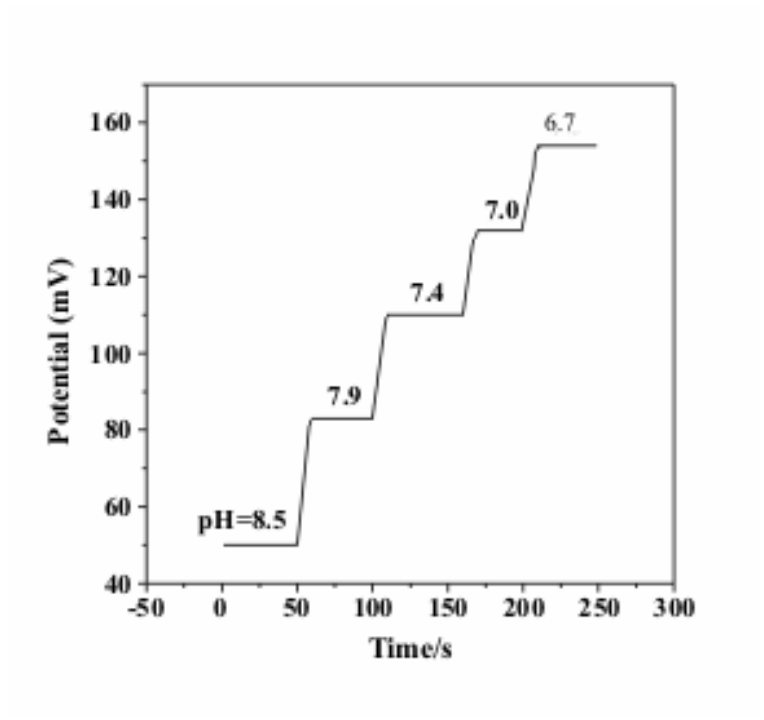
Figure 2 . Response of the membrane electrode based on 10.0 wt % SR in PVC to an injection of 1.0 M HCl into a buffer solution of pH 8.5 as the background